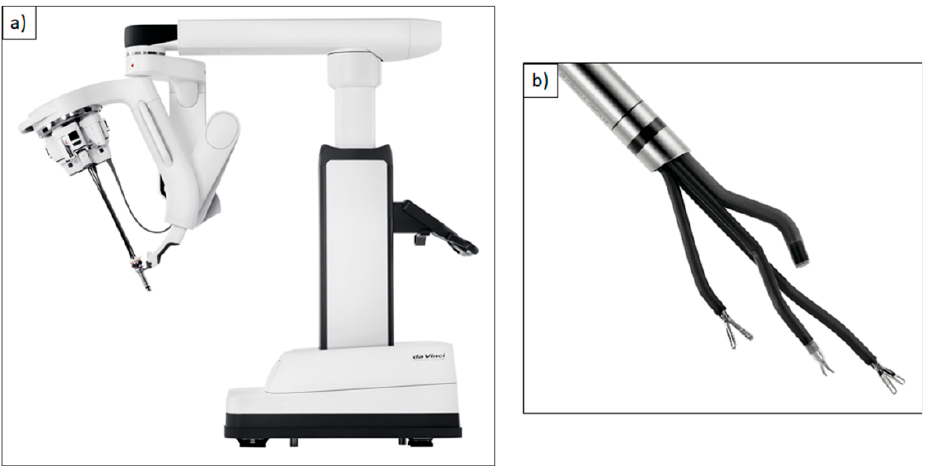
Figure 3. ( a ) DaVinci Single-Port (SP) ® robotic system; ( b ) Single 2.5 cm cannula containing three instrument arms and an endoscope. Reproduced with kind permission from Intuitive Surgical ® , Inc., Sunnyvale, CA, USA, © 2021.